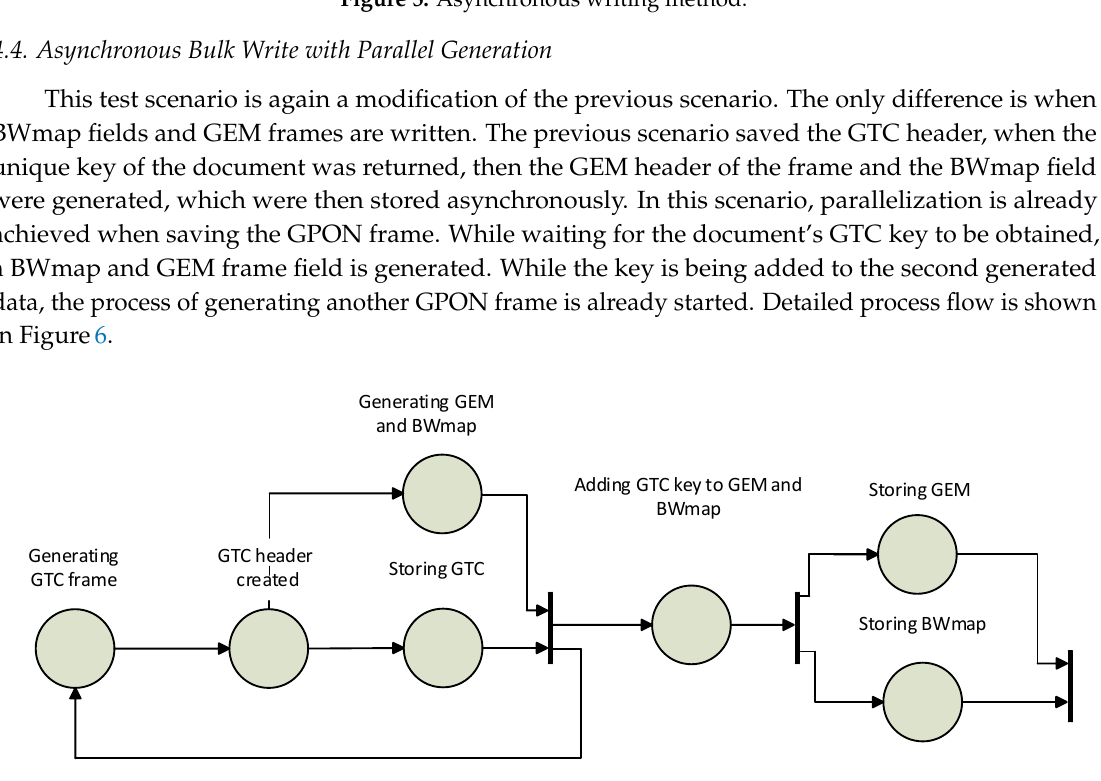
Figure 6. Asynchronous bulk write with parallel